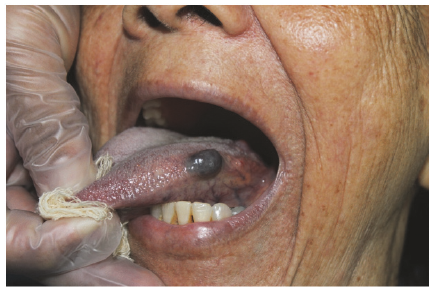
Figure 1: Hemangiomatous lesion on the left lateral border of the tongue.